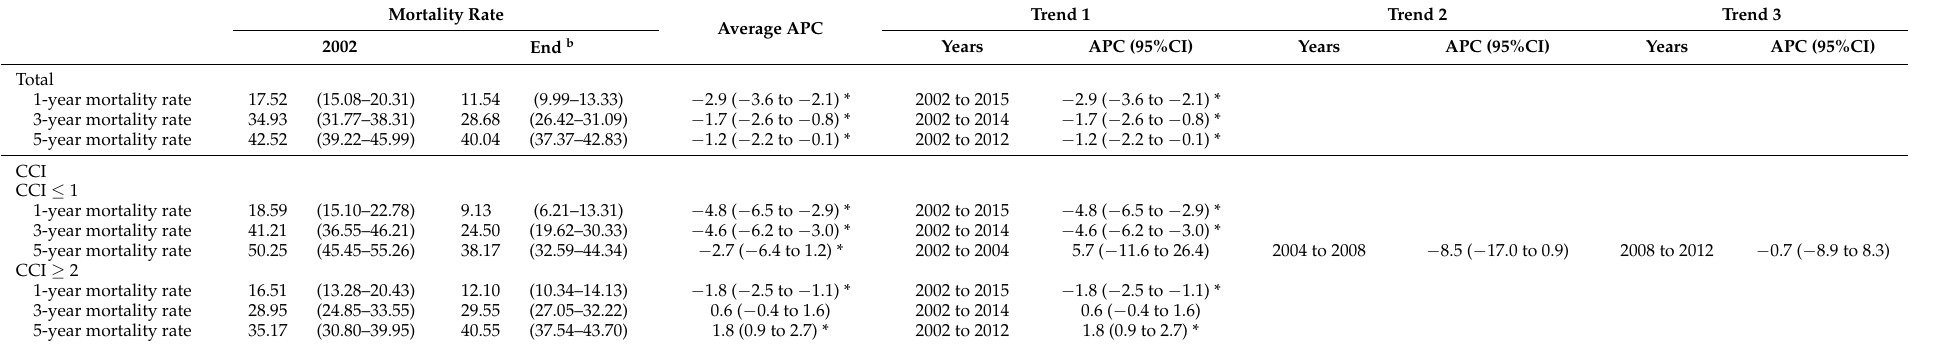
Table 5. Joinpoint analysis of ovarian cancer overall mortality a by Charlson comorbidity index (CCI) in Taiwan from 2002 to 2015.